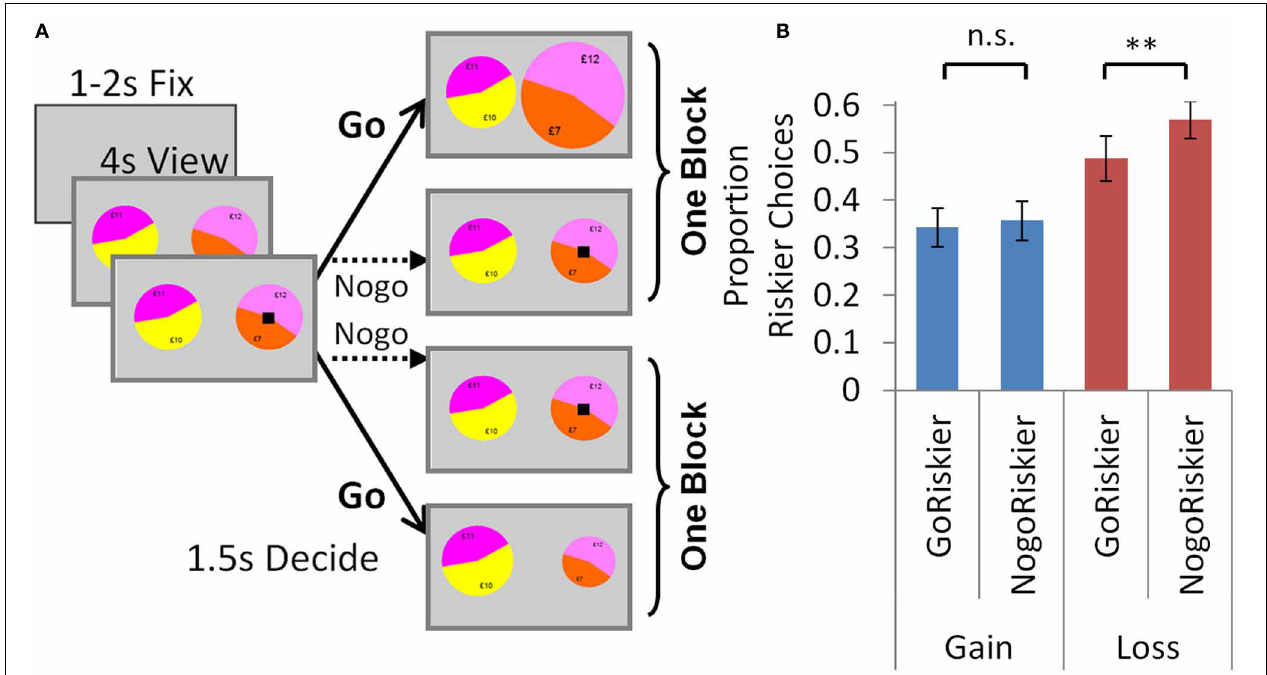
FIGURE 5 | Experiment 3b: go-nogo manipulation in the selection task. (A) To indicate in each trial which lottery would be selected by a go and which by a nogo response, the black square signaling the choice period appeared on one of the lotteries, and individuals responded by either accepting or rejecting it. In one block, individuals were instructed to go to accept the lottery with the black square. In the other block, individuals would no-go to accept the lottery with the black square. In each trial the lottery to be accepted or